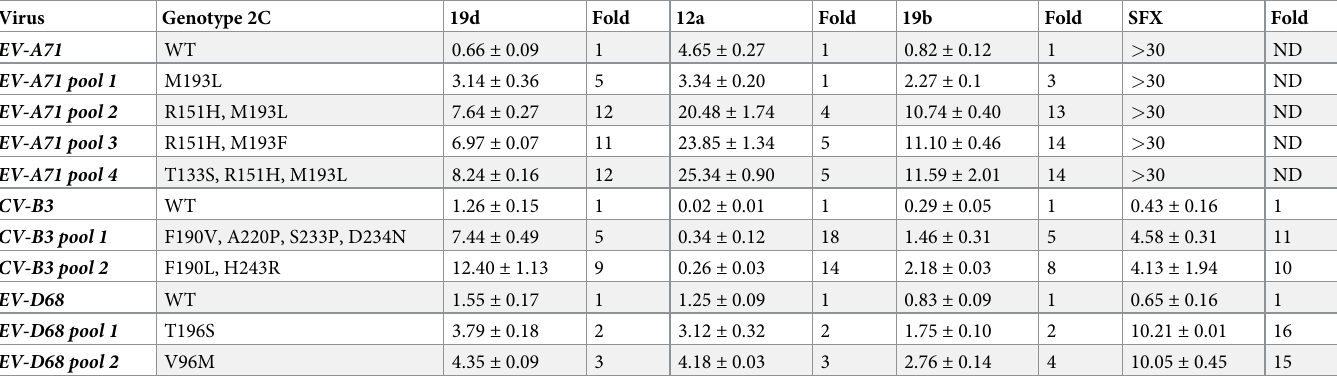
Table 4. Phenotypic characterization of 19d-resistant virus pools.